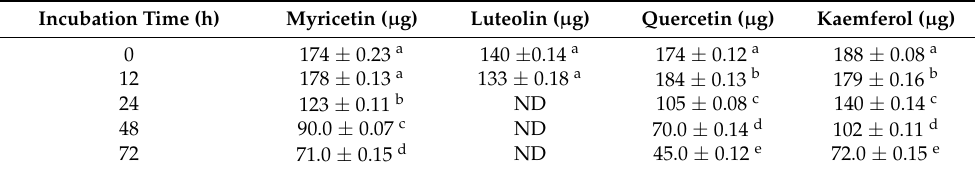
Table 3. Quantification of flavonols in rumen fluids after different incubation periods by HPLC-DAD